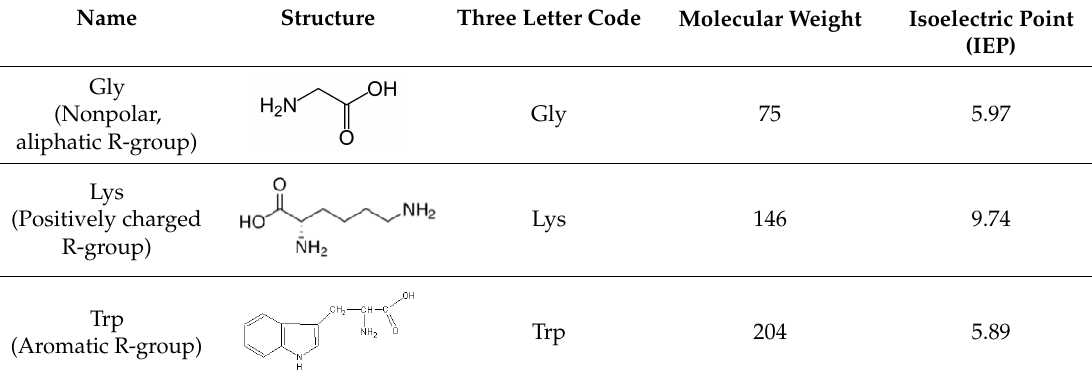
Table 1. Chemical structure and selected properties of glycine (Gly), lysine (Lys), and tryptophan (Trp).